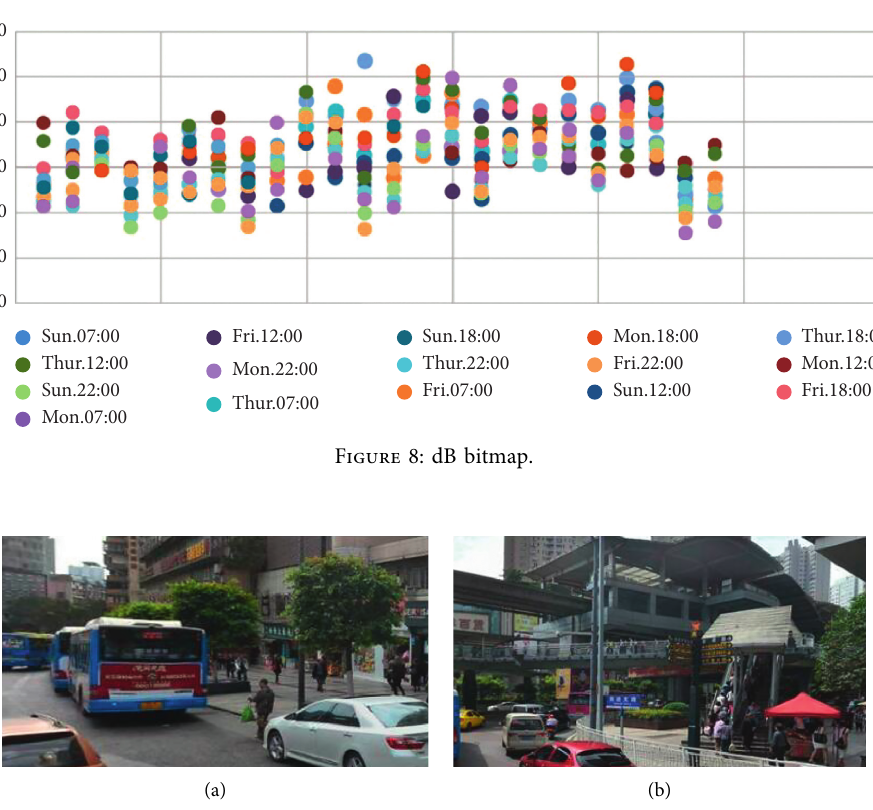
Figure 9: Example of a typical bus station (a) and light rail station (b) where the crowd concentration significantly influences the noise test